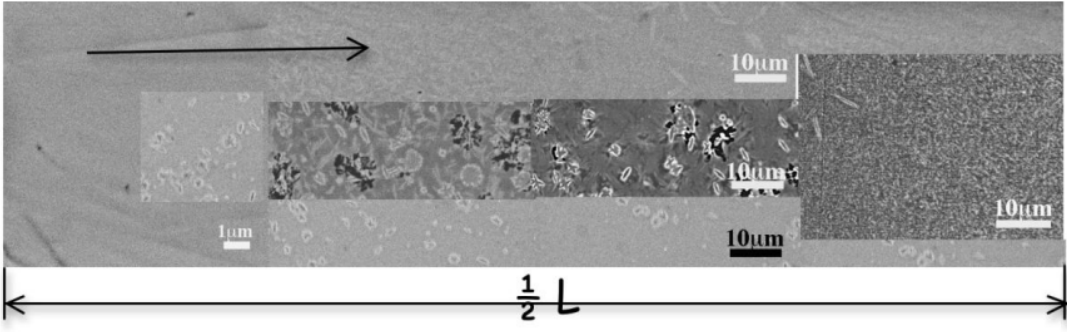
Figure 5. SEM-BEI micrographs of the cross-sectional microstructure evolution of Fe Ni Mo B Zr wedged ingot at about the half height area: from the border to the 50 16 6 18 10 center: uniform amorphous pattern, annular, lenticular grains and needles.